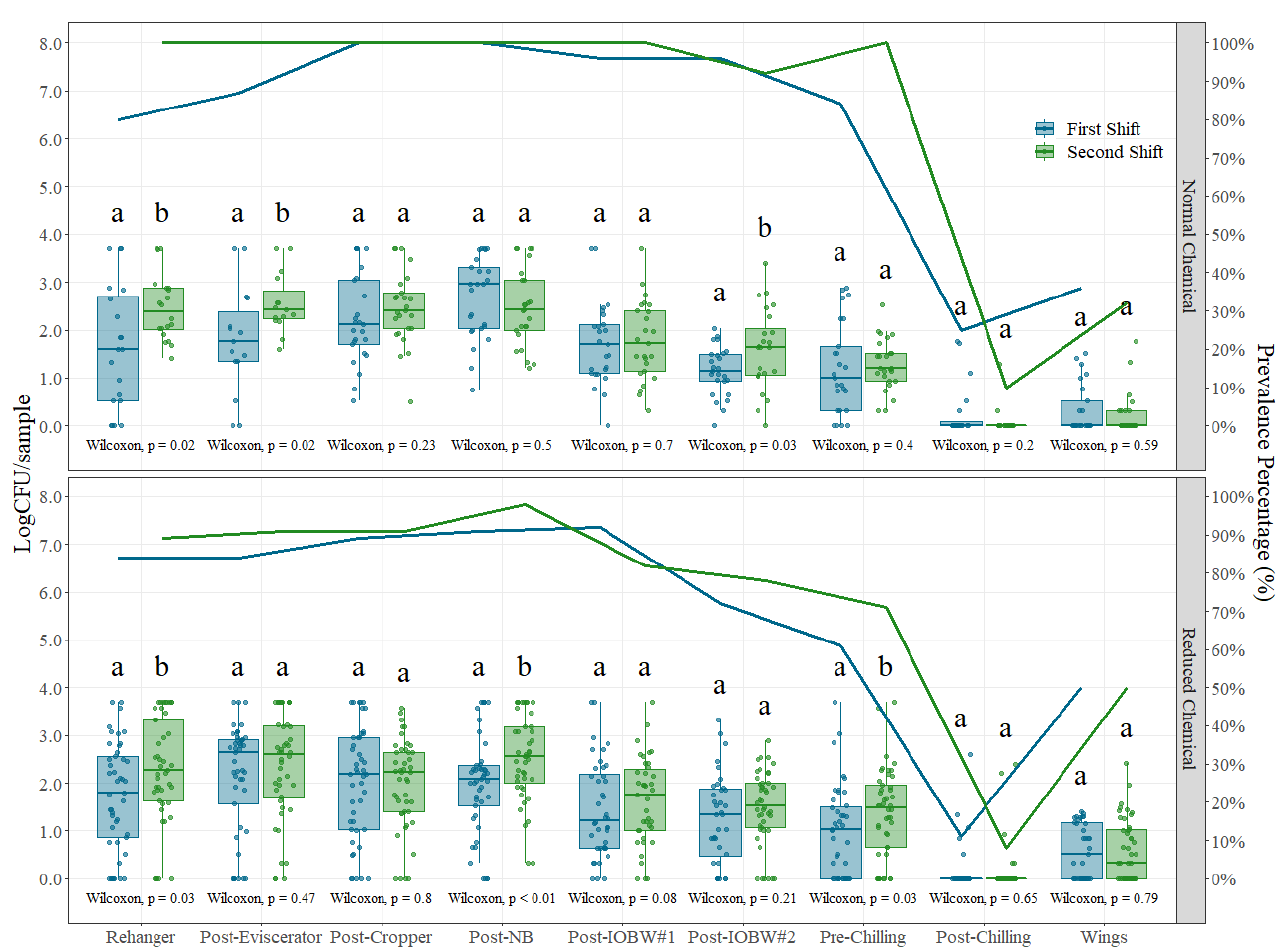
Figure 2. Campylobacter counts (Log CFU/sample) and prevalence (solid lines) on each of the nine sampling locations under normal process interventions ( above ) and reduced chemical process interventions ( below ) on chicken and part rinses collected during different shifts. In each boxplot, the horizontal line crossing the box represents the median, the bottom and top of the box are the lower and upper quartiles, the vertical top line represents 1.5 times the interquartile range, and the vertical bottom line represents 1.5 times the lower interquartile range. (a,b) For normal and reduced chemical interventions at each sampling location, boxes with different letters are significantly different according to Wilcoxon’s test analysis at p < 0.05. The points represent the actual data points.